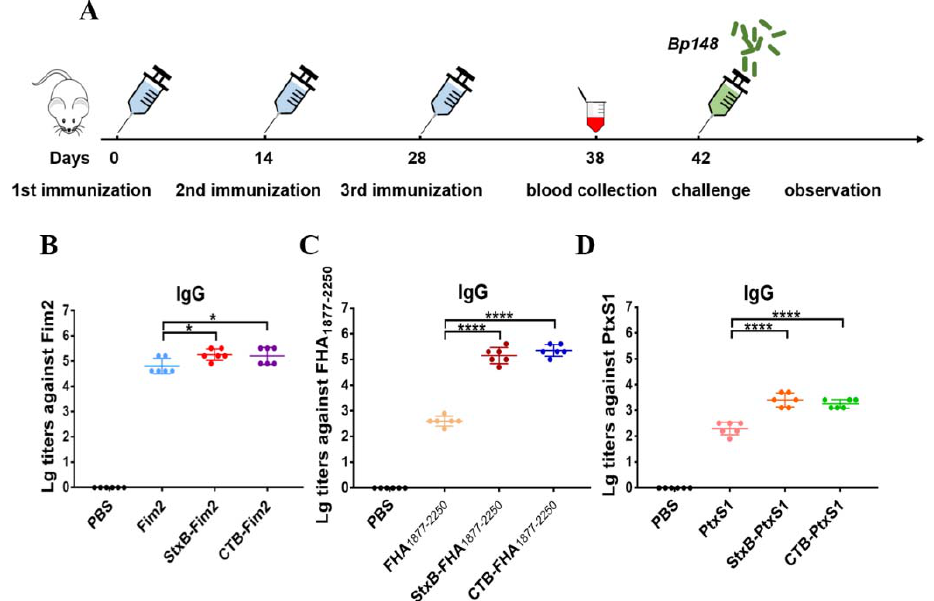
Figure 2. Antigen-specific serum antibody responses in mice after immunization. ( A ) Schematic diagram of the mouse immunization and evaluation experiment. ( B ) Serum IgG antibody titers against Fim2 antigen in mouse groups after their immunization with PBS, Fim2, StxB-Fim2, or CTB-Fim2. ( C ) Serum IgG antibody titers against FHA 1877–2250 antigen in mouse groups after their